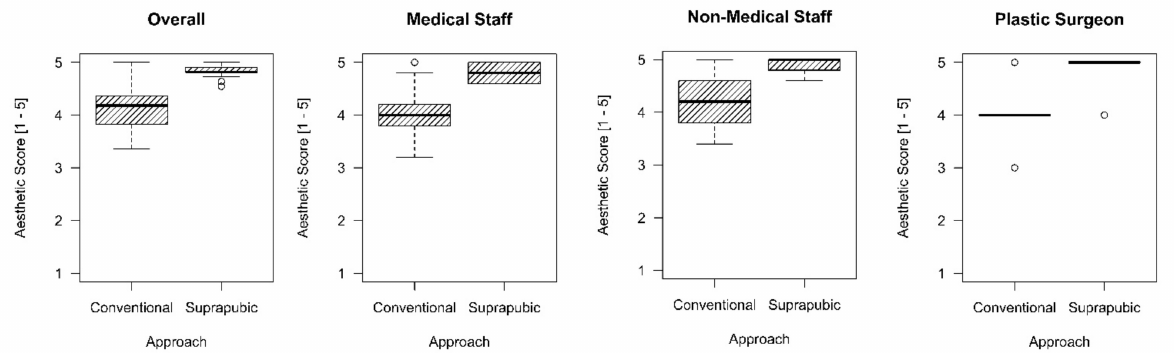
Figure 2. Boxplots demonstrating the distribution of the ordinal aesthetic scoring among conventional versus suprapubic laparoscopic cholecystectomy cases. The boxplots show the distribution for—from left to right—pooled overall rating, pooled medical staff rating, pooled nonmedical staff rating, and the rating from the plastic surgeon.